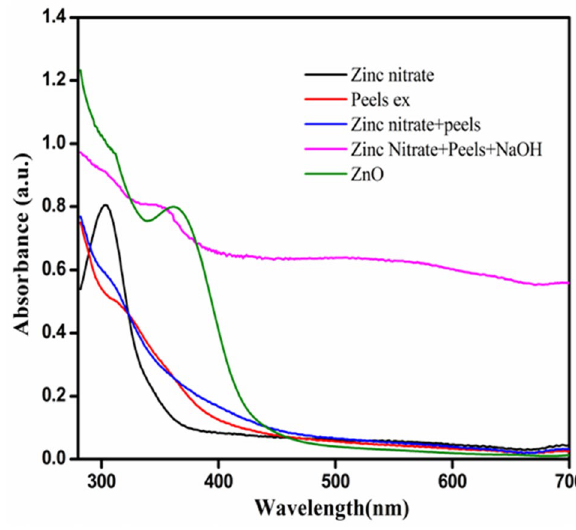
Fig. 2 UV–vis absorption spectra of ZnO NPs